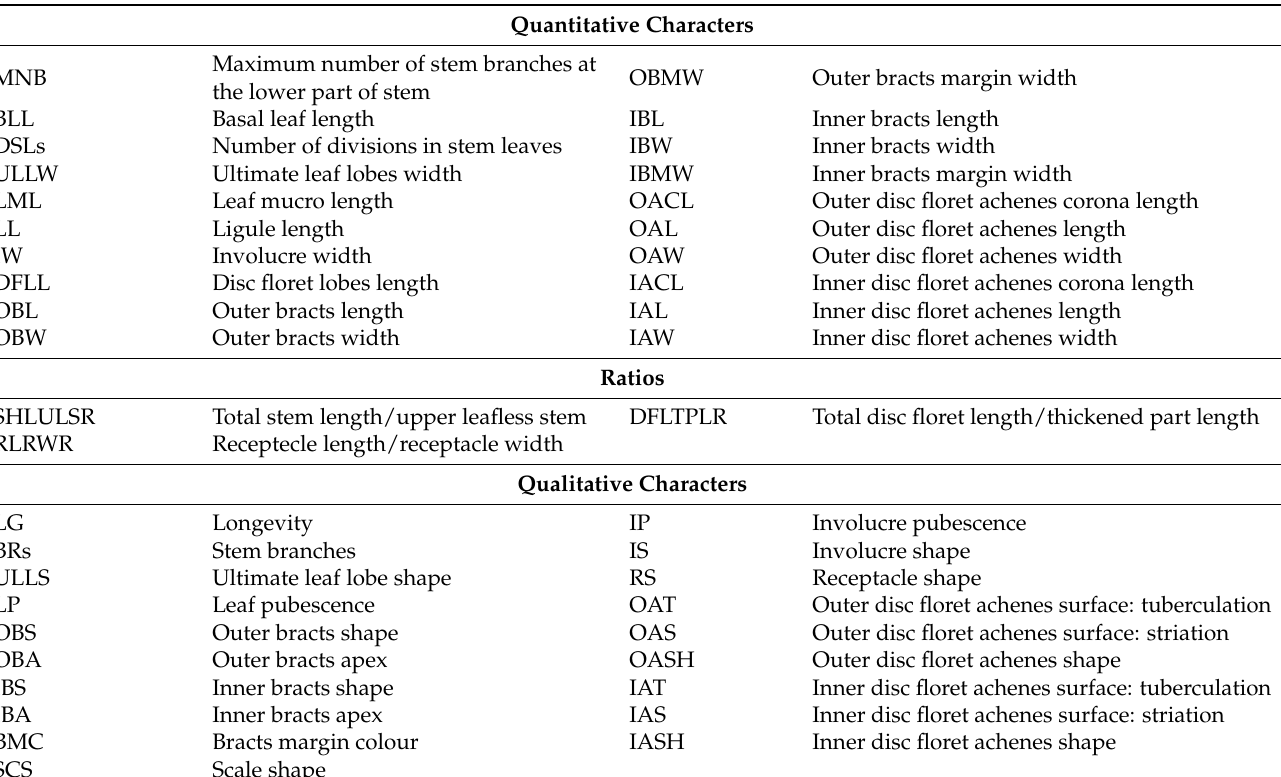
Figure 4. Relative contribution of the quantitative ( a ) and qualitative ( b ) morphological characters to the FA of Figure 2. Table 1. Quantitative characters, ratios and qualitative characters used in the morphometric analysis of the Anthemis macedonica group. All measurements in